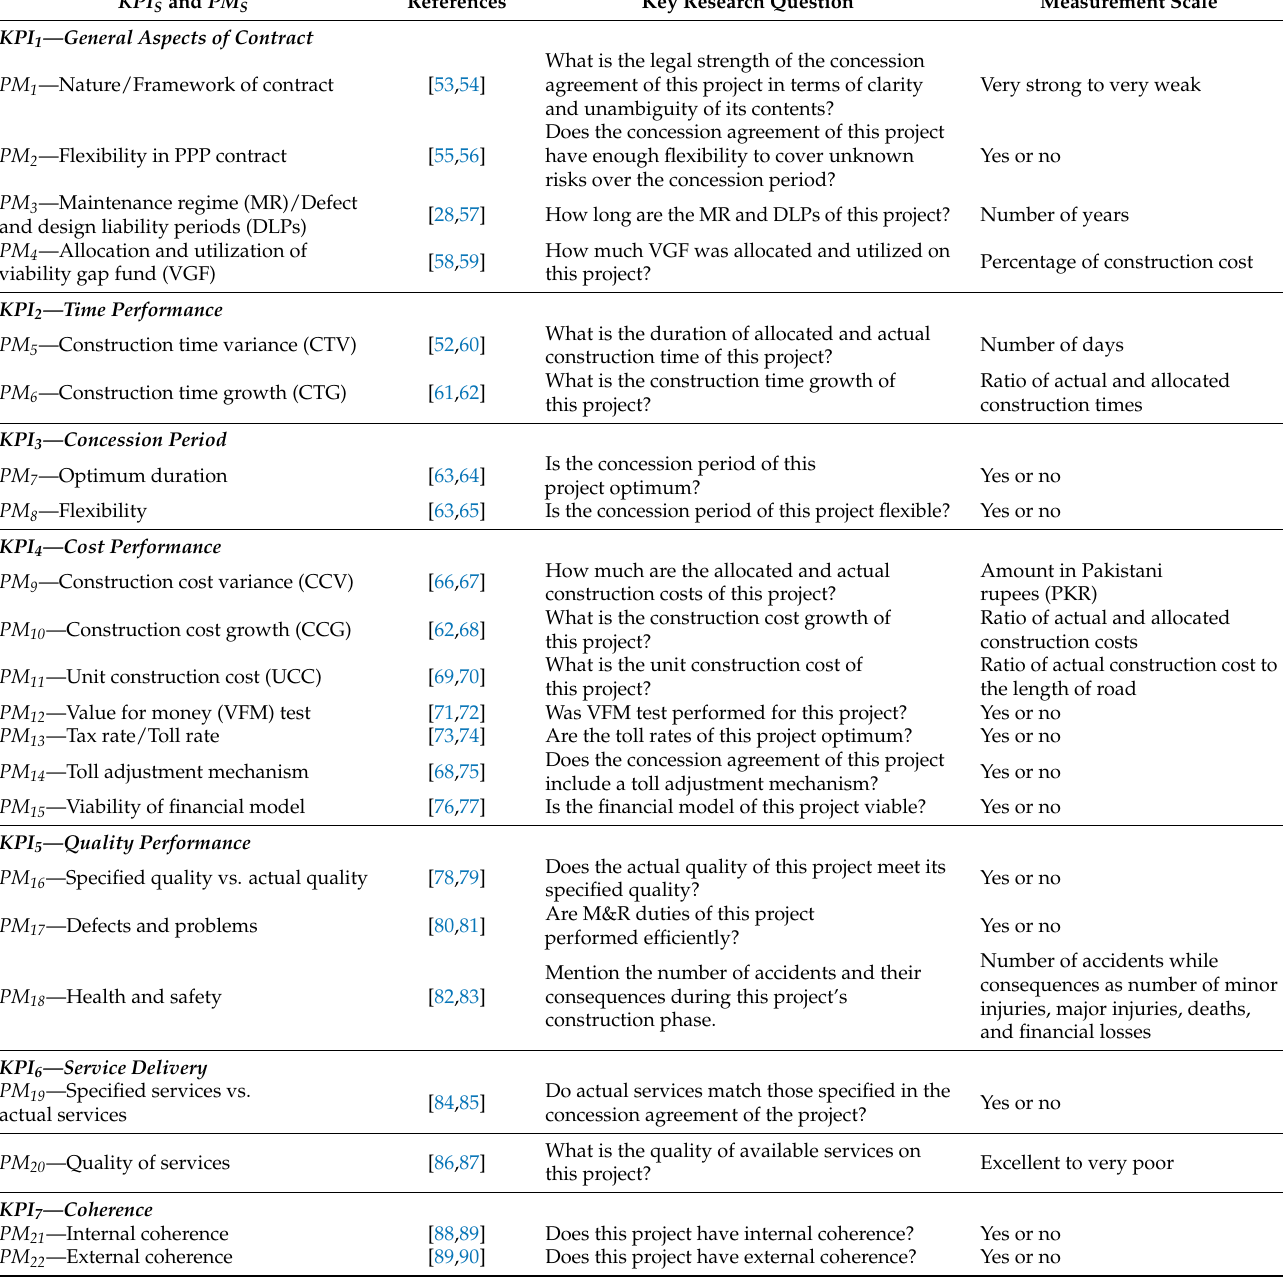
Table 1. Performance Evaluation Framework for Public Private Partnership